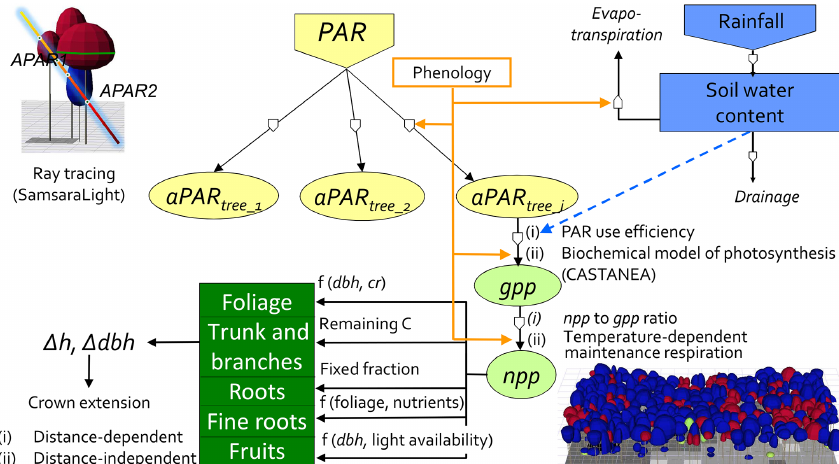
Figure 1. Conceptual diagram of the HETEROFOR model. The incident PAR radiation is absorbed by individual trees using a ray-tracing model (SamsaraLight library). Then, the absorbed PAR (aPAR) is converted into gross primary production (gpp) based on the PAR use efficiency concept (first option) or with a biochemical model of photosynthesis (second option). The photosynthesis calculation depends on the soil water potential, which is updated hourly thanks to the water balance module described in detail in de Wergifosse et al. (2019). The net primary production (npp) is obtained using a npp to gpp ratio or by subtracting the growth and maintenance respiration (the latter being temperature dependent). npp is first allocated to foliage using an allometric equation function of tree diameter (dbh) and crown radius (cr). All of these processes (radiation interception, photosynthesis, respiration and evapotranspiration) depend on the foliage development stage, which is determined based on the phenology module. The carbon allocated to fine roots is determined based on a fine root-to-foliage ratio, dependent on the tree nutritional status. Fruit production is calculated with an allometric equation based on dbh and on light availability. The remaining carbon is allocated to structural compartments (roots, trunk and branches) using a fixed proportion for the below-ground part. dbh and height growth ( (cid:49) dbh and (cid:49)h ) are deduced from the change in aboveground biomass by deriving and rearranging an allometric equation. Finally, crown extension is predicted with a distance-dependent or distance-independent